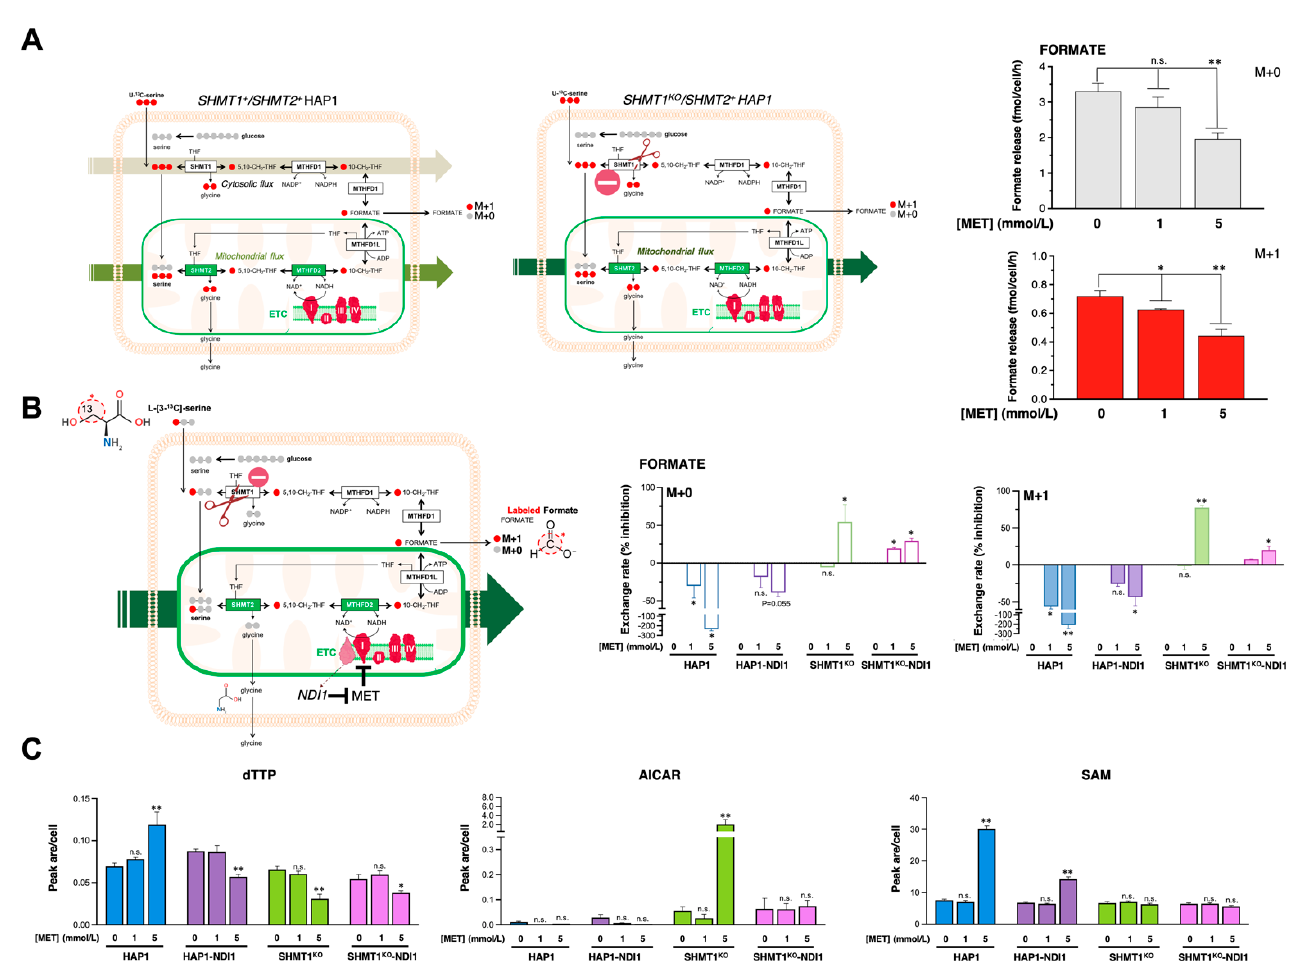
Figure 5. Metformin targets the mitochondrial serine catabolism via mitochondrial complex I and SHMT2. ( A , B ) Models summarizing mammalian SGOC metabolism in which the oxidation of the third carbon of serine to formate relies on functional mitochondria in a complex I-dependent manner [17,32,52]. Formate produced via mitochondrial SHMT2 is released into the cytosol where it supplies the 1C demand for nucleotide synthesis [53]. Formate can be also recycled back to re-synthesize serine via cytosolic 1C metabolism [47]. Thus, in cells with defective mitochondrial 1C metabolism, the cytosolic pathway is reverted, compensating for the loss of mitochondrial formate production. The metformin-resistant Saccharomyces cerevisiae protein NDI1 is a single-subunit NADH dehydrogenase that oxidizes NADH similar to the multi- subunit mammalian complex I without proton pumping or reactive oxygen species generation [16,54]. Graphs show formate release ( A ) and exchange rates of formate ( B ) M + 0 and M + 1 isotopologues in the extracellular milieu of SHMT1 + /SHMT2 + HAP1, SHMT1 KO-HAP1 cells, and isogenic derivatives engineered to overexpress NDI1, all cultured for 24 h in the absence or presence of graded concentrations of metformin (MET). ( C ) Changes in dTTP, AICAR, and SAM following treatment of SHMT1 + /SHMT2 + HAP1, SHMT1 KO-HAP1 cells, and isogenic derivatives engineered to overexpress NDI1 with 1 and 5 mmol/L MET. Data are presented as means ( columns ) ± SD ( bars ) ( n = 3 cultures representative of at least two independent experiments). Comparisons of means were performed by ANOVA. p values < 0.05 and < 0.005 (versus untreated controls) were considered to be statistically significant (denoted as * and **, respectively; n.s. not